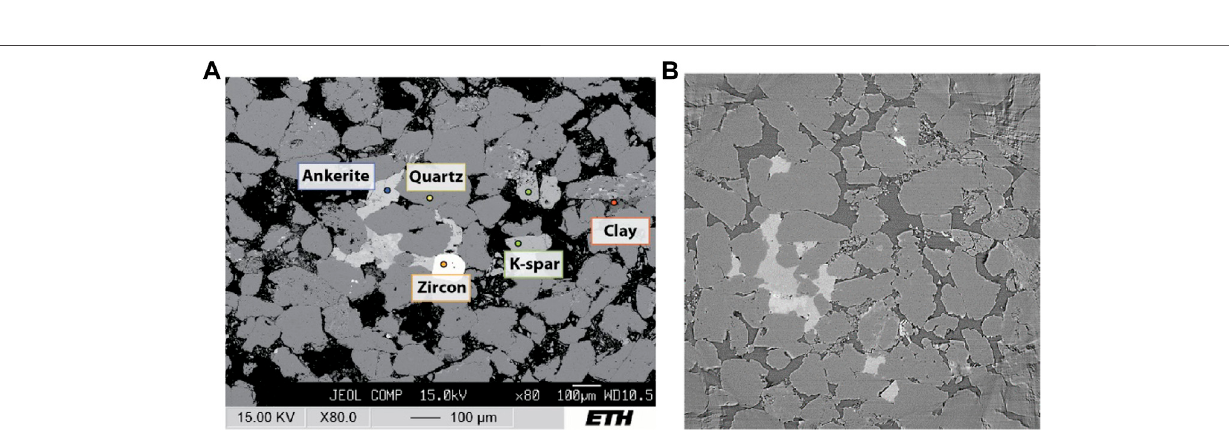
Frontiers in Physics |